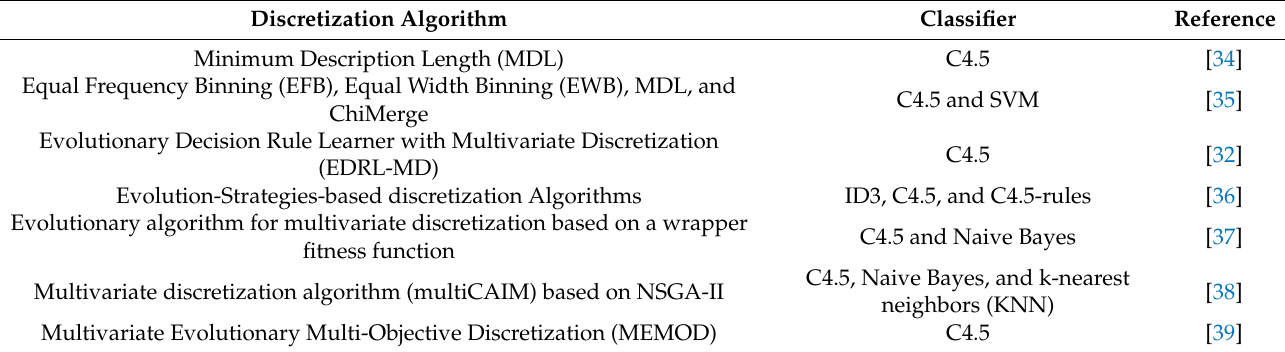
Table 1. Overview of research related to multivariate discretization with interpretable ML